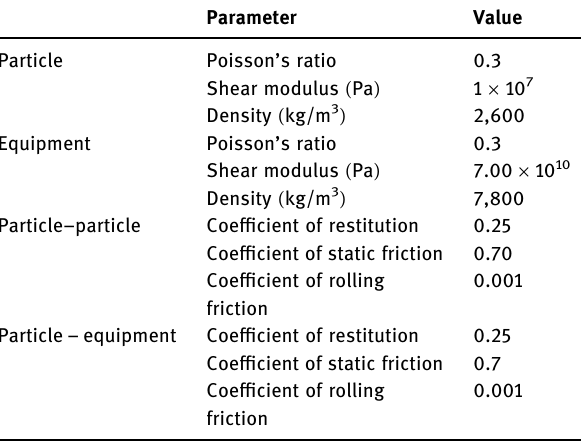
Table 1: Numerical parameters employed in the DEM simulations